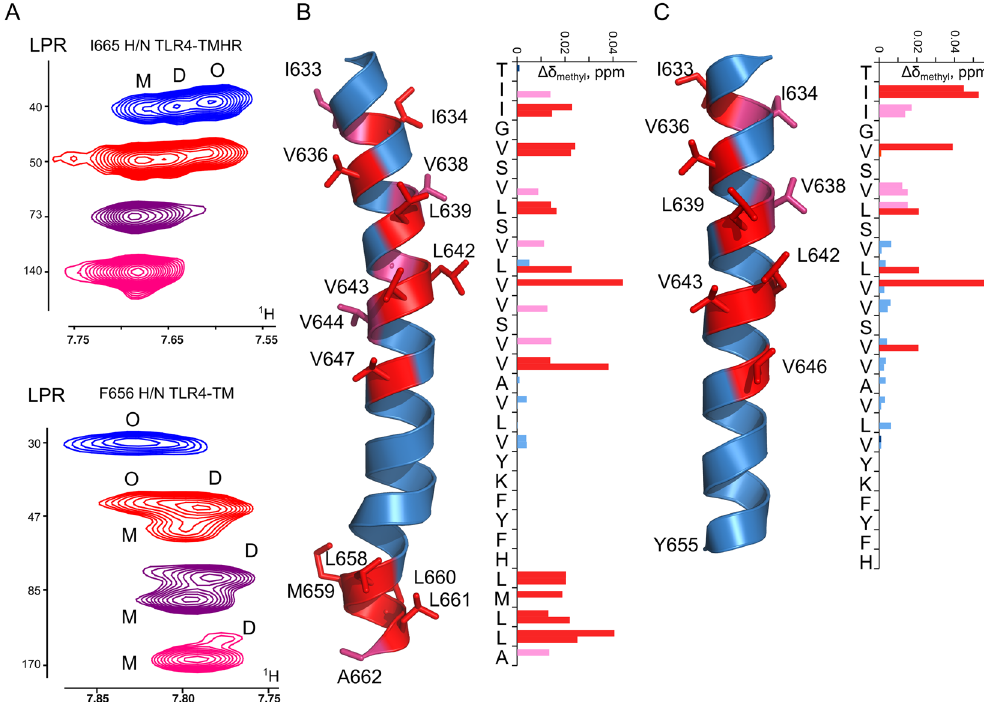
Figure 3. Dimerization of TLR4 TM domain in DPC micelles. ( A ) Fragments of the 1 H, 15 N-TROSY spectra of TLR4-TMICL (I665, above) and TLR4-TM (F656, below) in DPC micelles, recorded at various LPR, as indicated. Peaks, corresponding to the monomeric (M), dimeric (D) and oligomeric (O) states are indicated. ( B , C ) Chemical shift variations of the methyl groups of TLR-TMICL (B) and TLR-TM (C), occurring upon the dimerization. Side-chains with generalized chemical shift changes exceeding 0.02 ppm are shown in red, and side chains with generalized chemical shift changes between 0.01 and 0.02 are shown in